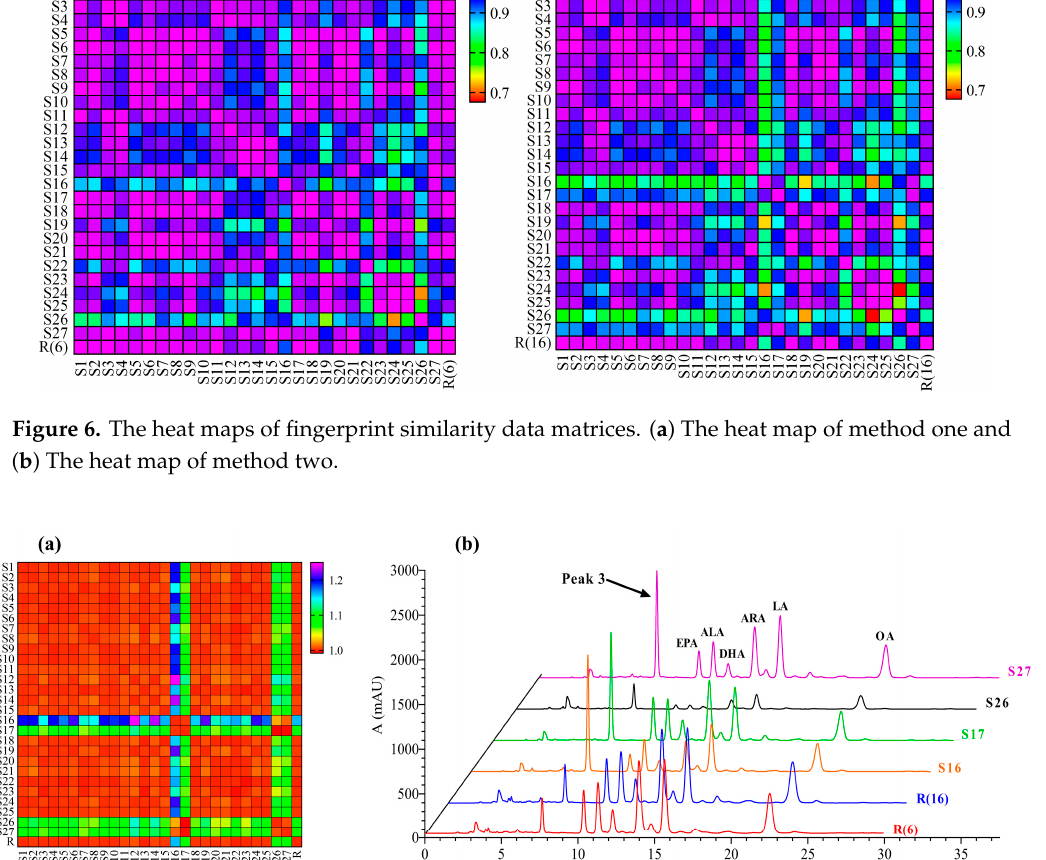
Figure 7. ( a ) The heat map showed the difference of similarity matrix between two fingerprint methods, ( b ) Comparison of samples chromatograms (S16, S17, S26, and S27) and reference chromatograms (R(6), R(16)).